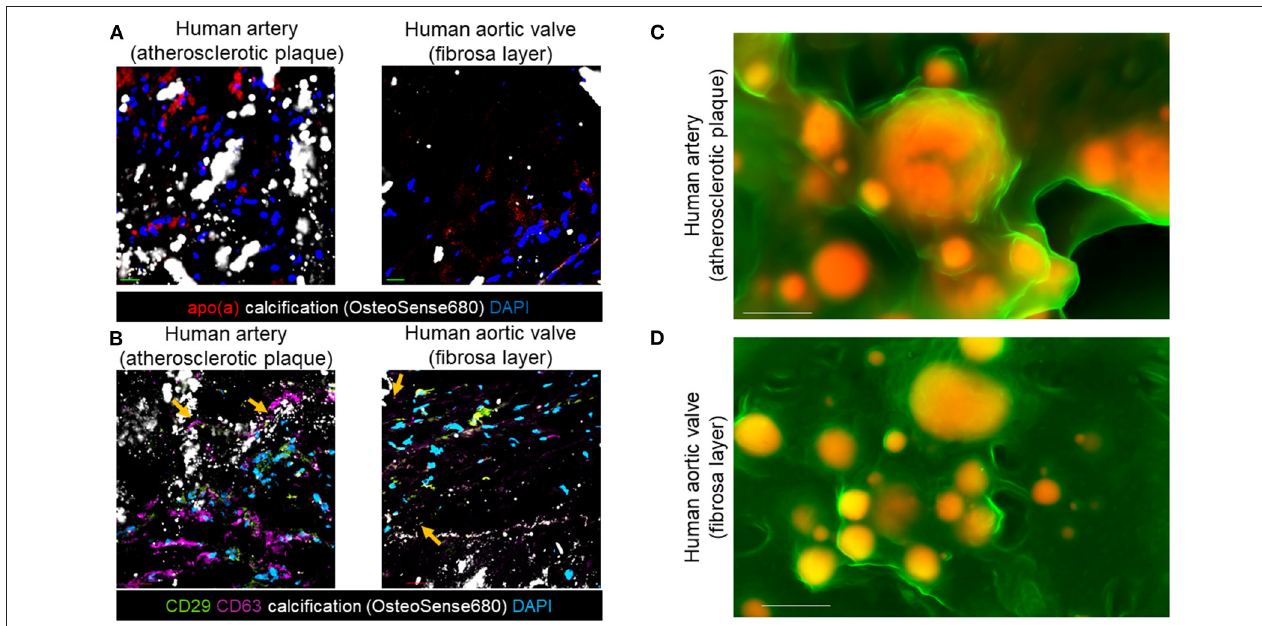
FIGURE 2 | EV markers and Lp(a) localized near calcification in human cardiovascular tissues. (A) Apolipoprotein(a) (apo[a]) and OsteoSense680 (calcification) confocal immunofluorescence in human atherosclerotic arteries and human aortic valve tissues ( n = 5 donors, with example images shown). (B) CD29, CD63, and OsteoSense680 confocal immunofluorescence in human atherosclerotic arteries and human aortic valve tissues ( n = 5 donors, with example images shown). Scale bars = 20 µ m. Orange arrows indicate CD29 and CD63 immunofluorescence in acellular regions near microcalcification. (C) Density-dependent scanning electron microscopy of calcification (yellow/orange color) in extracellular matrix (green color) of human atherosclerotic arteries and (D) aortic valves ( n = 5 donors, with example images shown). Scale bars = 1 µ